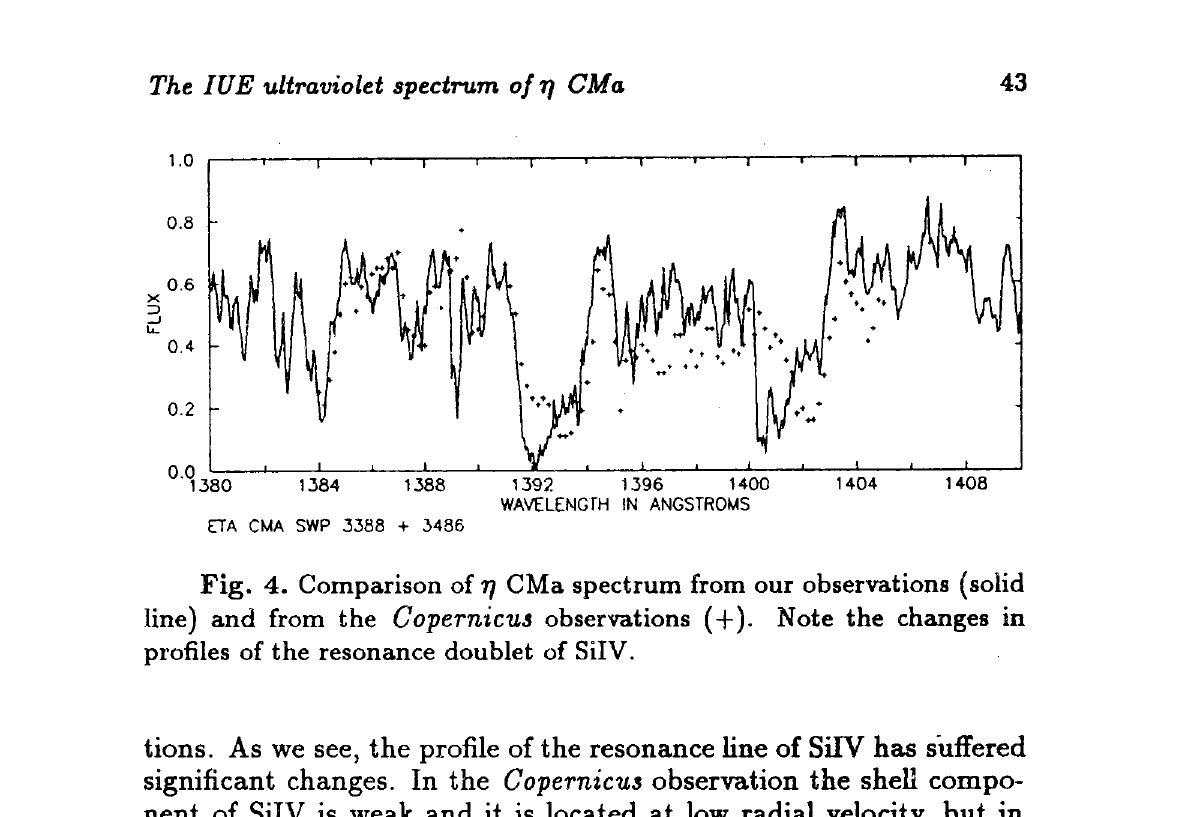
Fig. 4. Comparison of 77 CMa spectrum from our observations (solid line) and from the Copernicus observations (+). Note the changes in profiles of the resonance doublet of